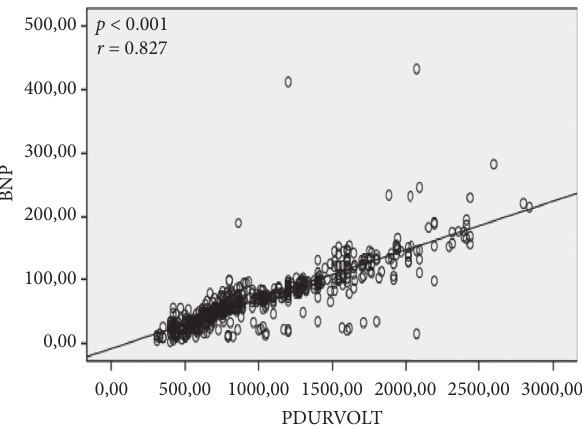
Figure 2: Correlation between P wave duration/P wave voltage and BNP. There is a significant correlation between P wave duration/P wave voltage and BNP ( r � 0.827, p < 0 . 001). BNP: brain natriuretic